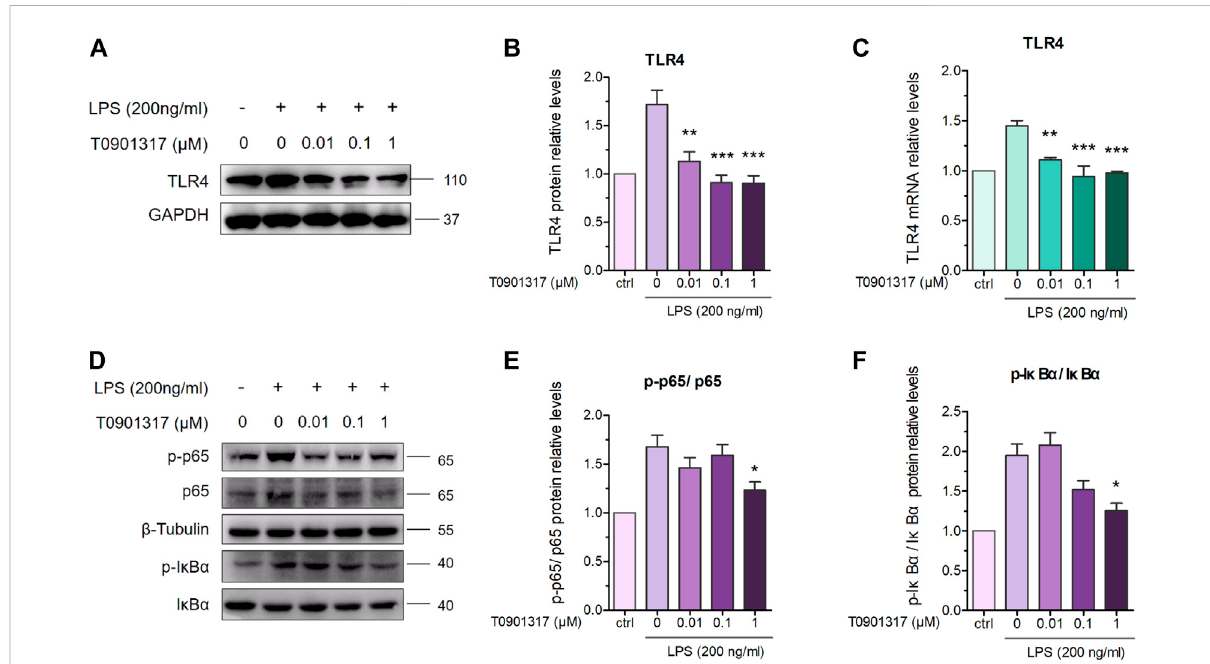
FIGURE 3 T0901317 inhibits protein levels in TLR4-mediated NF- κ B pathway. (A,B) RAW264.7 macrophages treated with LPS (200 ng/mL) and T0901317 (0, 0.01, 0.1, or 1 μ M) for 18 h, then protein levels of TLR4 were measured by western blot. TLR4 protein level was normalized to GAPDH. (C) RAW264.7 macrophages were pretreated with T0901317 (0, 0.01, 0.1, or 1 μ M) for 18 h, then stimulated with or without LPS (200 ng/mL) for 3 h. TLR4 mRNA level was measured by qPCR. (D – F) RAW264.7 macrophages were pretreated with T0901317 (0, 0.01, 0.1, or 1 μ M) for 18 h, then stimulatedwithorwithoutLPS(200 ng/mL)for1 h.PhosphorylatedI κ B α ,phosphorylatedp65,I κ B α andp65proteinlevelsweremeasuredbywestern blot. Phosphorylated I κ B α protein level was normalized to I κ B α , and phosphorylated p65 protein level was normalized to p65, respectively.